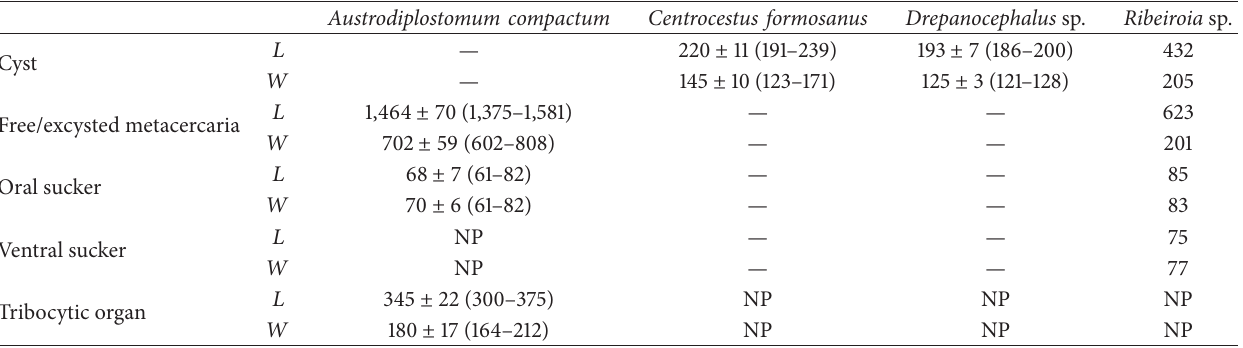
Table 1: Measurements of metacercariae of four species of trematodes found in naturally infected specimens of Nile tilapia ( Oreochromis niloticus ) collected in Pampulha reservoir, Belo Horizonte, Minas Gerais, Brazil. Austrodiplostomum